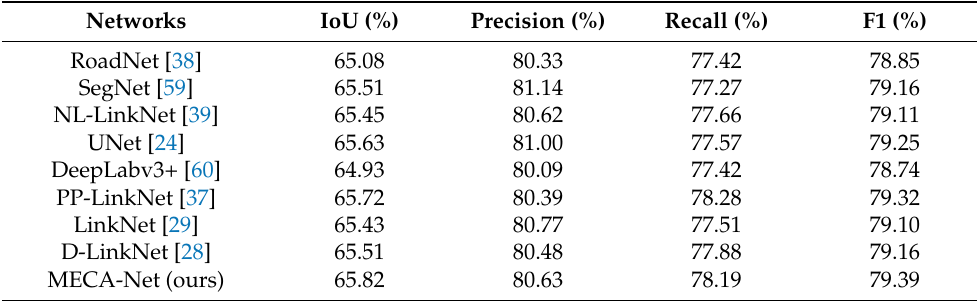
Table 2. Quantitative evaluation results of different networks on the Massachusetts dataset.